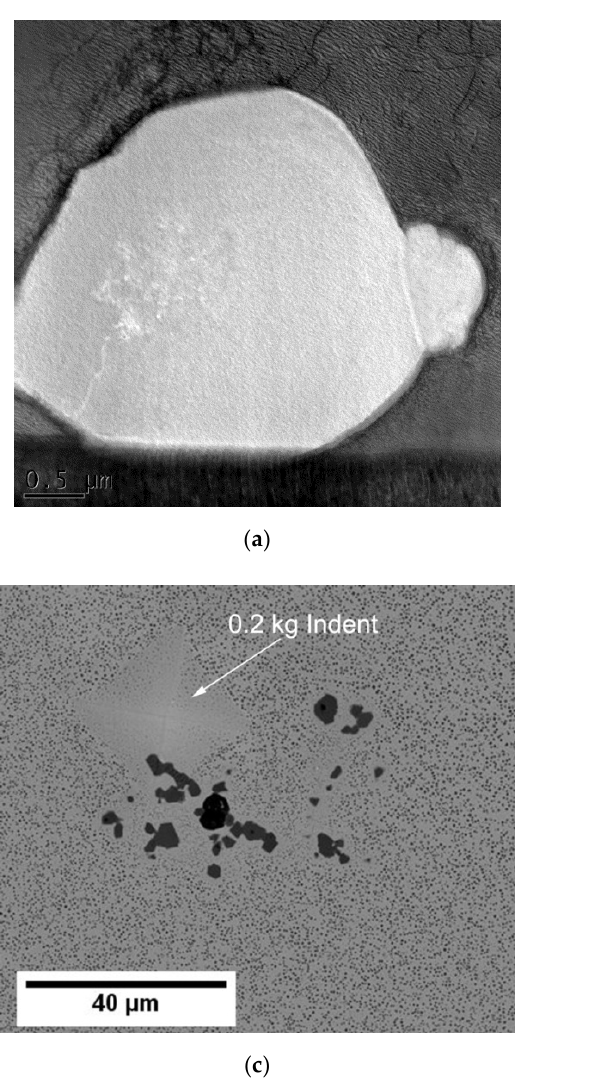
Figure 8. ( a ) TEM micrograph of a TiN; ( b ) TEM-EDS line-scan analysis showing MgO impurity inside the TiN; and ( c , d ) a low and high magnification micrograph showing that the TiN is very sensitive to stress.